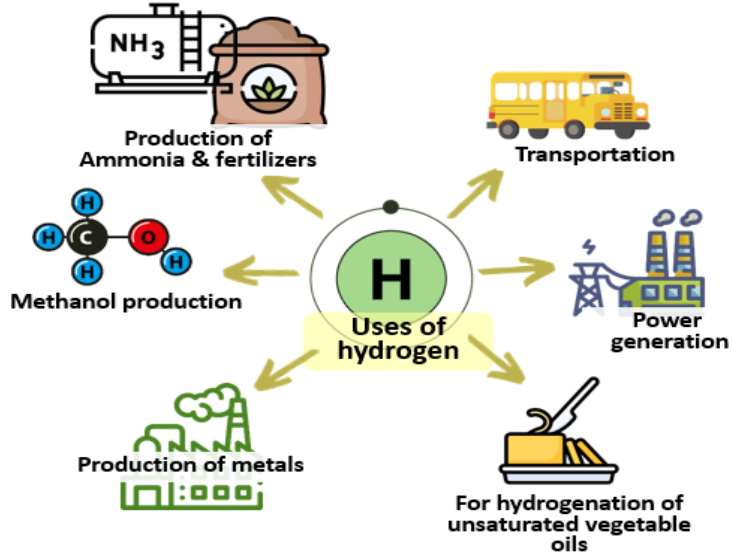
Figure 3. Several applications of H 2 .